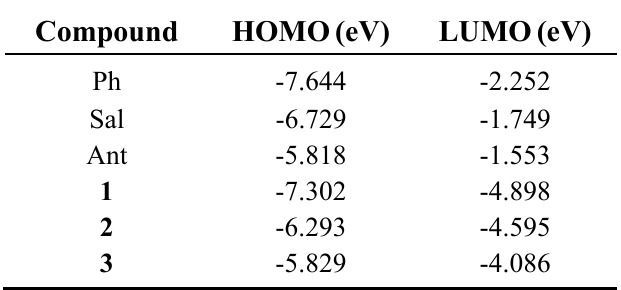
Table 6. HOMO and LUMO energies of the free ligands and copper